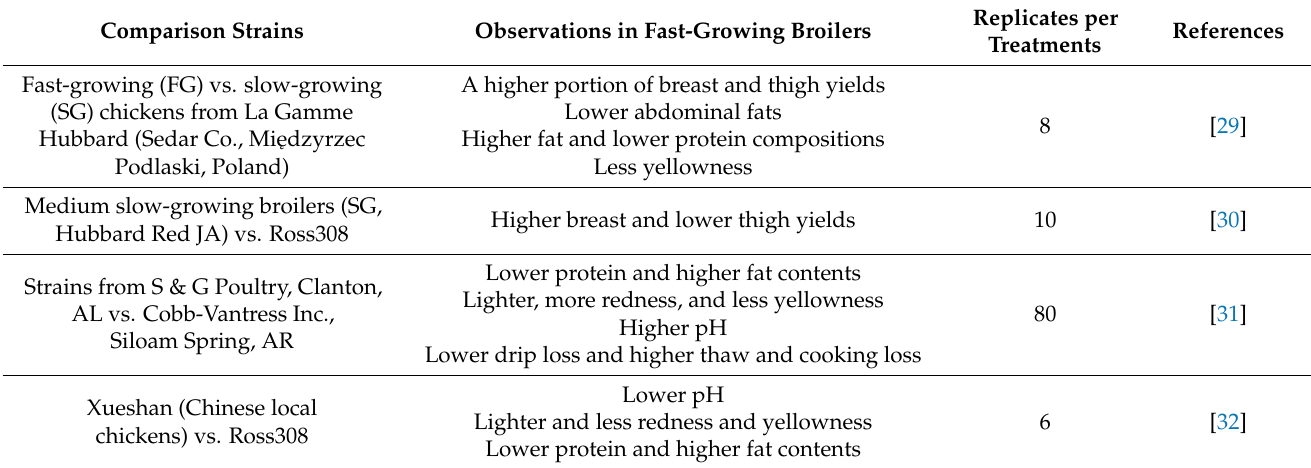
Table 1. Differences in meat quality in slow- and fast-growing